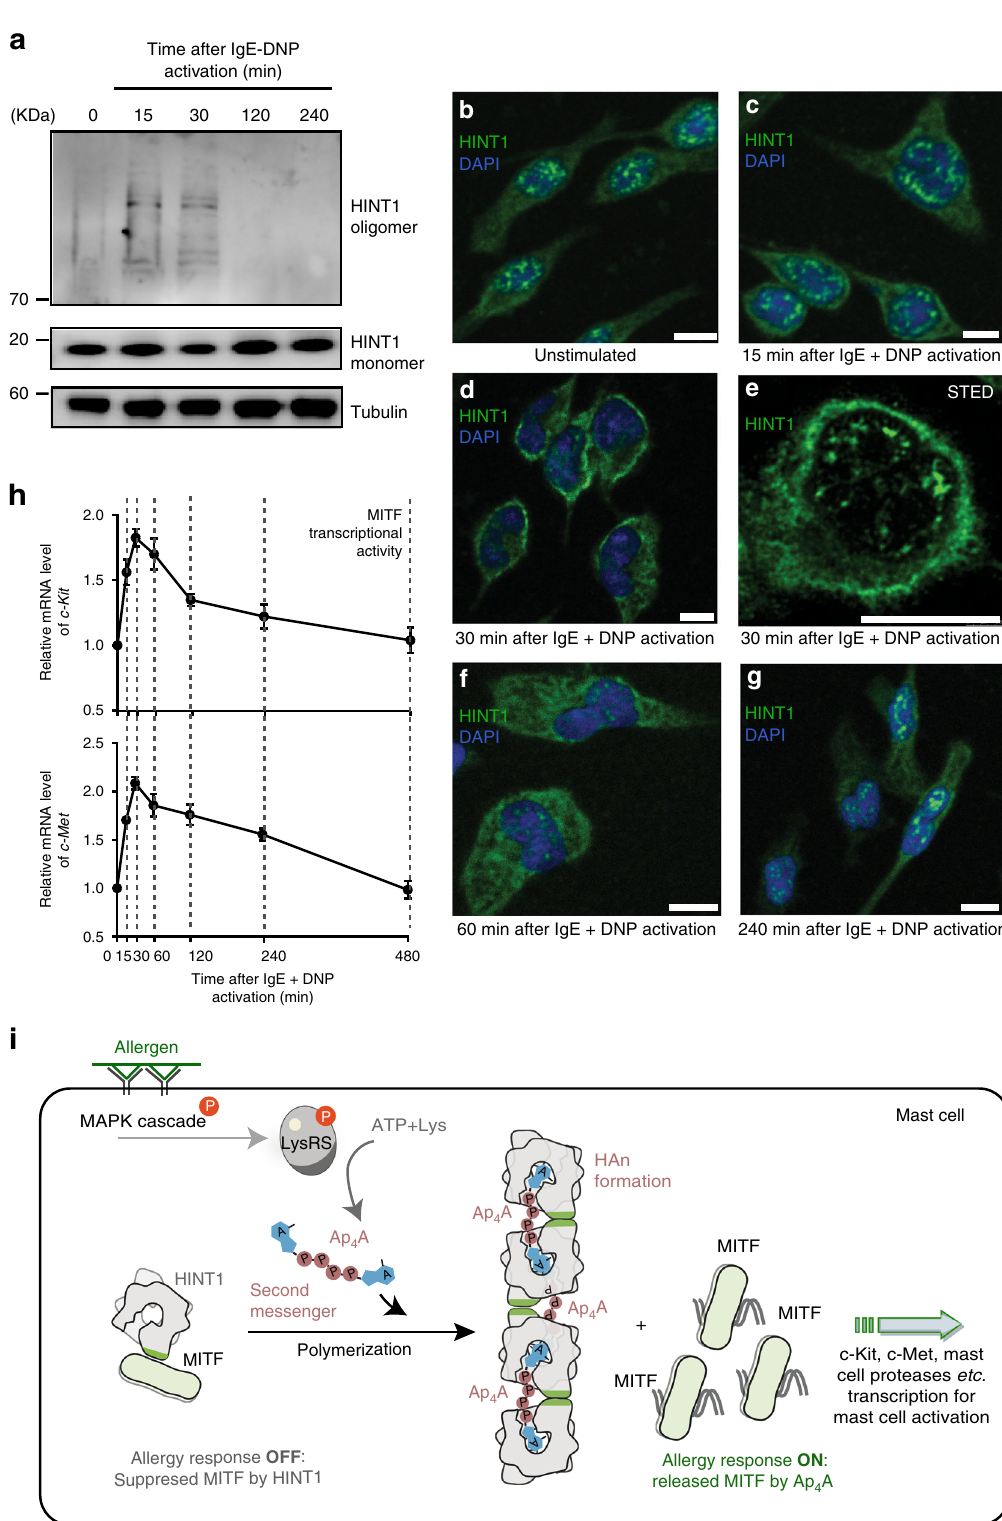
Fig. 4 HINT1 polymerizes in stimulated RBL cells. a Western blottings of the endogenous HINT1 following by the IgE and antigen stimulation. 0 indicates the unstimulated state. Source data are provided as a Source Data fi le. b – g Endogenous HINT1 in Rat basophilic leukemia (RBL) cell following the IgE and antigen stimulation (0 – 4 h) were immunostained and visualized by confocal laser scanning microscope or stimulated emission depletion microscope (STED). Scale bars, 10 μ m. Nuclei were labeled with DAPI. One representative experiment out of three is shown. h The transcript level of c-Met and c-Kit following the IgE and antigen stimulation. Error bars represent the SEM of three experimental repeats. Source data are provided as a Source Data fi le. i Schematic cartoon showing Ap 4 A induces the formation of HAn polymer to release MITF for transcriptional activity in allergic